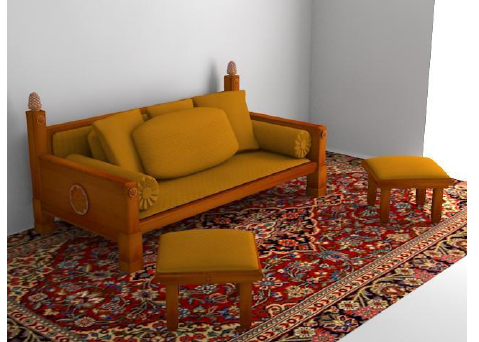
Figure 3. Simple 3D model of single height level except floor and ceil(Marbelar, 2013).